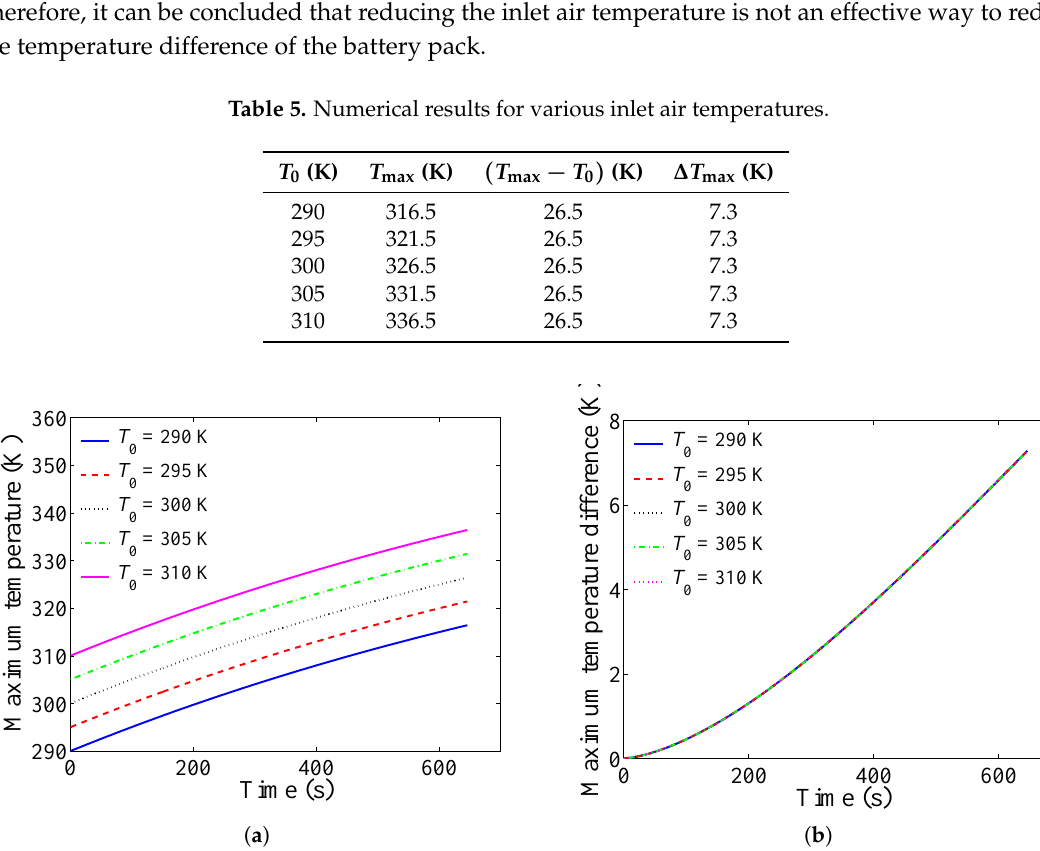
Figure 7. Comparison of numerical results for various inlet air temperatures. ( a ) Maximum temperature; ( b ) maximum temperature